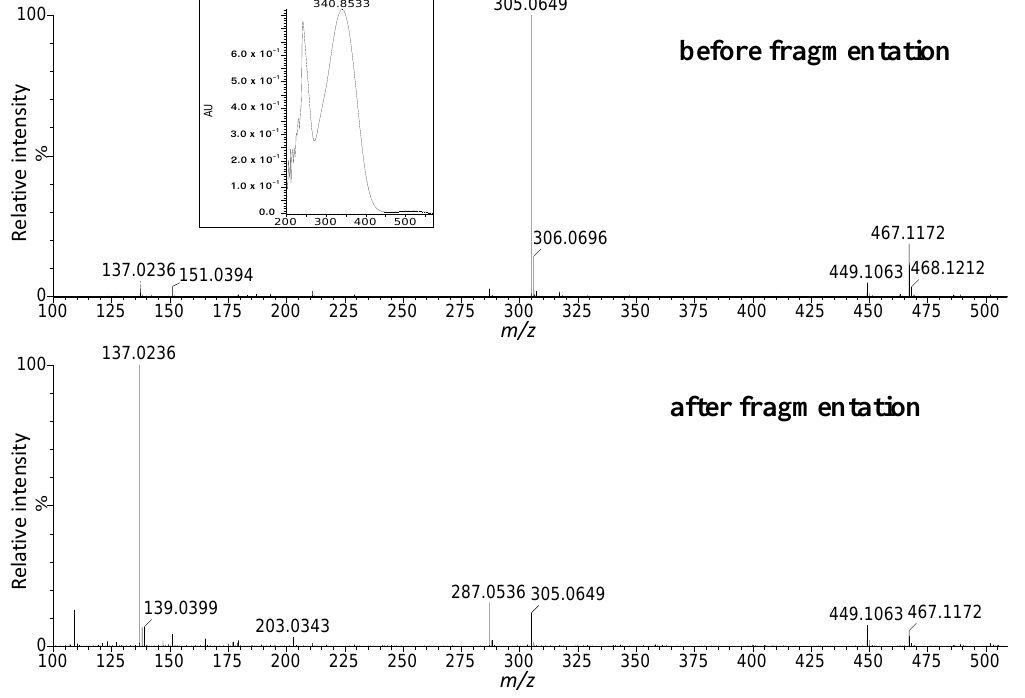
Figure 1. Mass spectra of the ions of taxifolin 7- O -hexoside in positive mode before and after fragmentation and UV/Vis spectra.